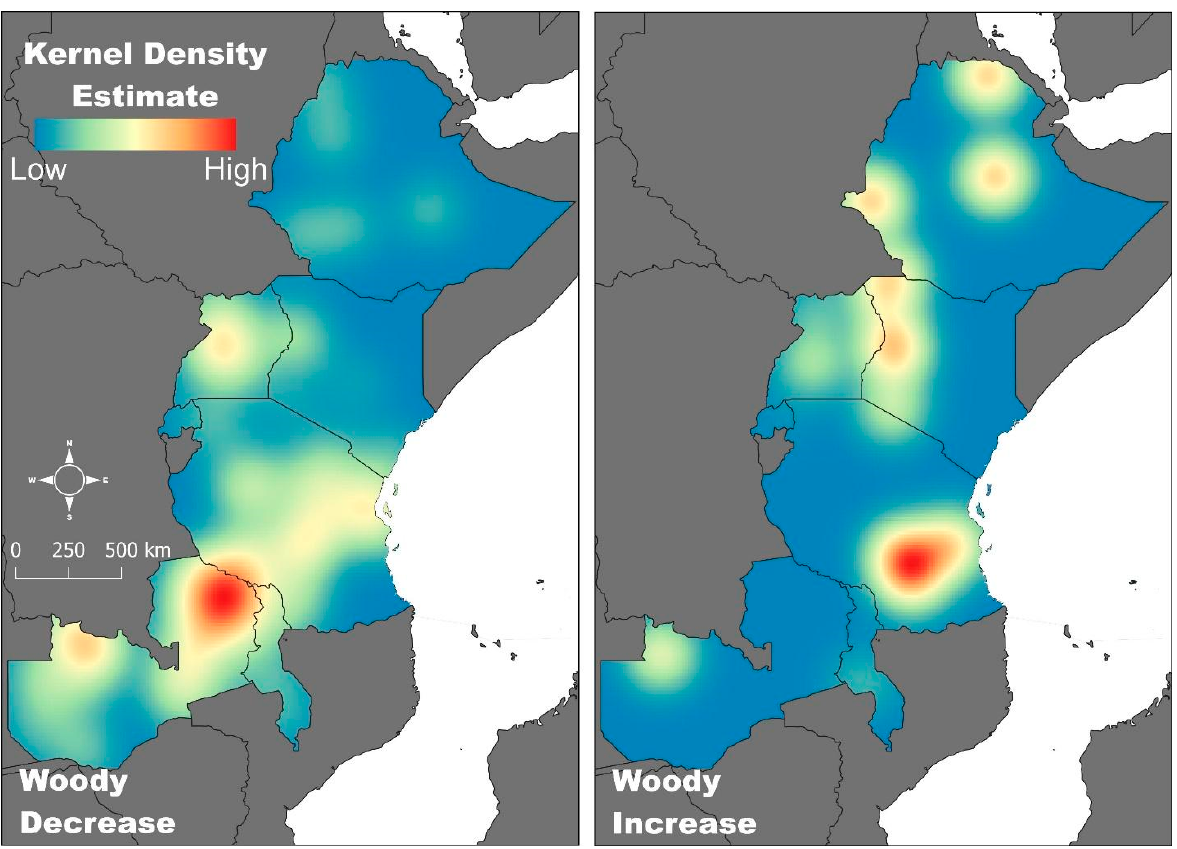
Figure 11. Hotspot analysis of land cover conversion resulting in a reduction in woody vegetation class ( left ) and increasing ( right ).